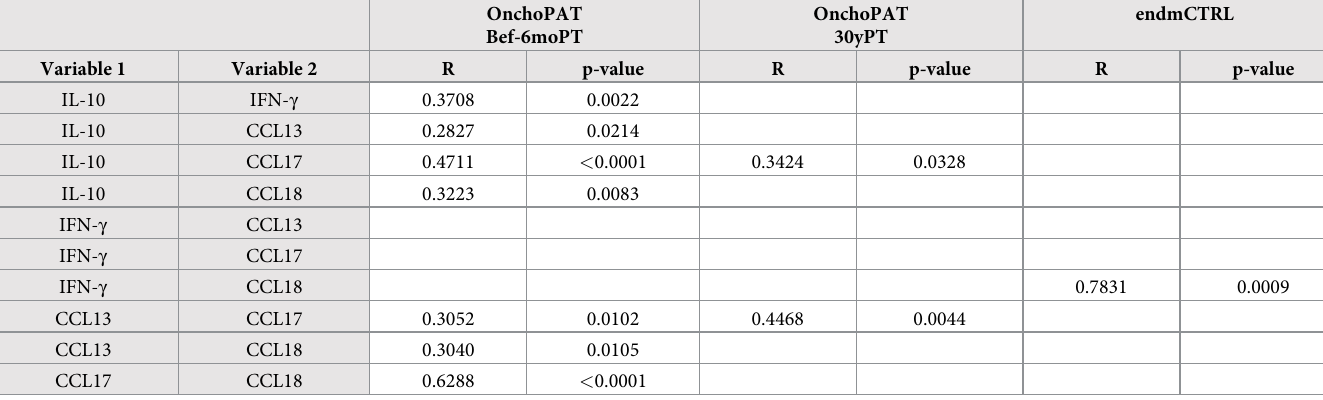
Table 3. Pairwise correlations of cytokines and chemokines. The significant correlations between the OvAg-induced cytokine and chemokine productions in onchocer- ciasis patient (OnchoPAT: Bef-6moPT, 30yPT) and O . volvulus negative endemic controls (endmCTRL) are listed with the coefficient R and the p-value; not significant cor- relations were